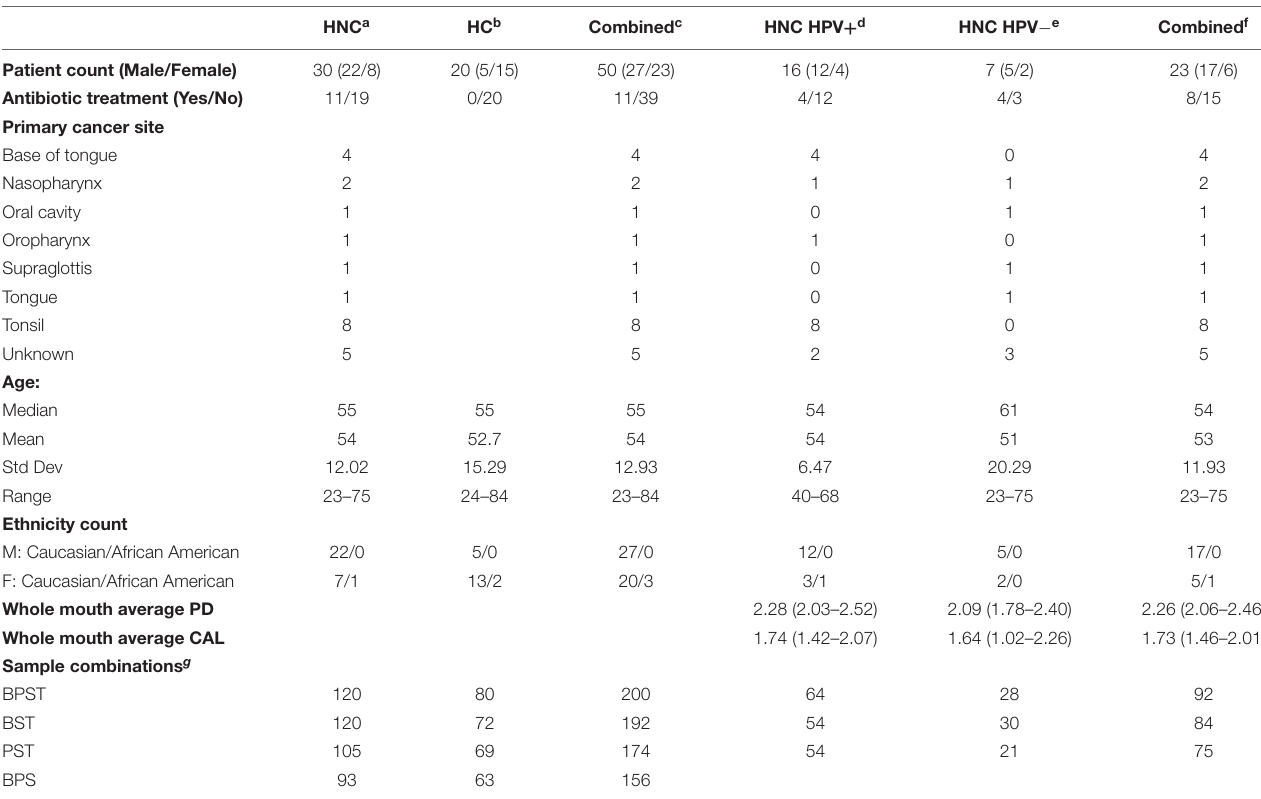
TABLE 1 | Patient demographics and clinical